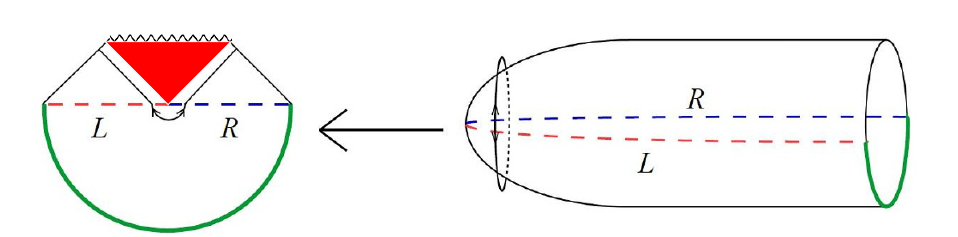
Figure 5 . The winding one tachyon mode that condenses at the tip of the cigar appears to be related to the folded string that (cid:12)lls up the entire SL(2 ; R ) k = U(1) BH interior. with strings (see (cid:12)gure 5). It seems reasonable to suspect that the wave function of